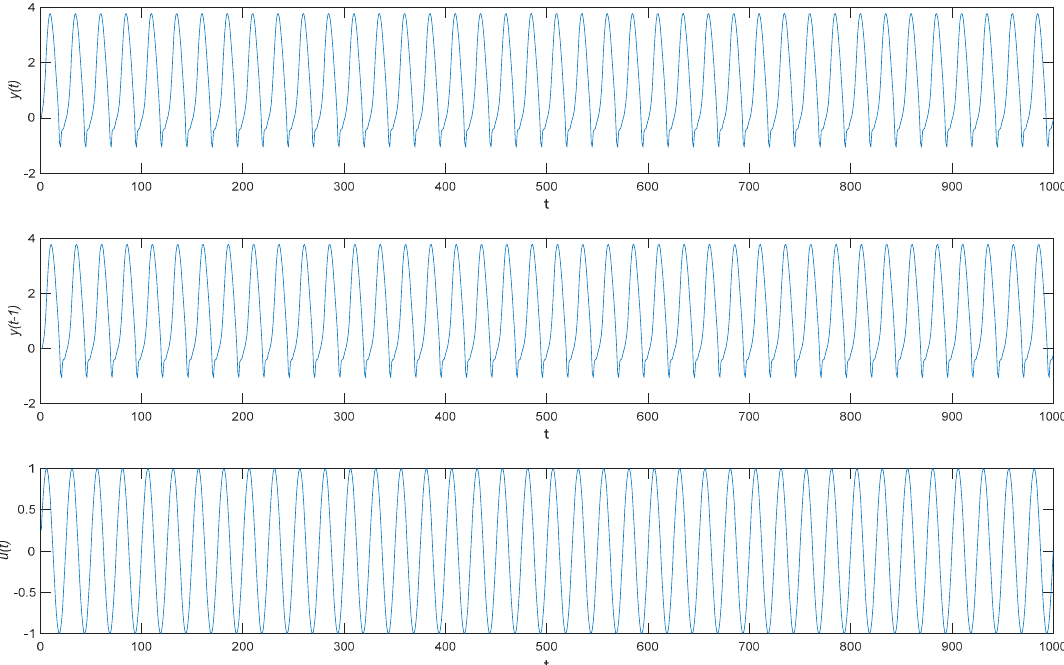
Figure 2. Input curve of ISCO-SVM model of nonlinear system.